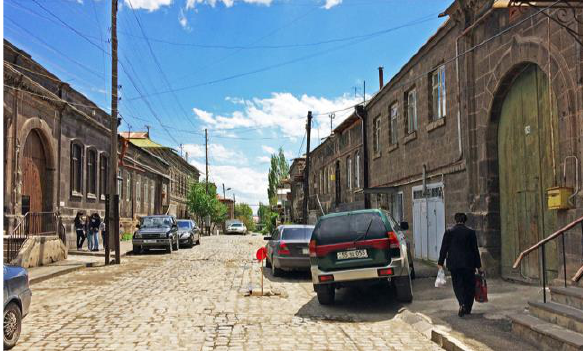
Figure 9. Vernacular ensemble of Gorganyan